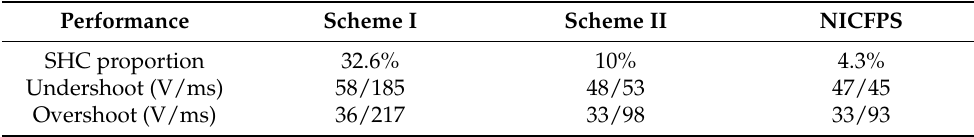
Table 2. Simulation results